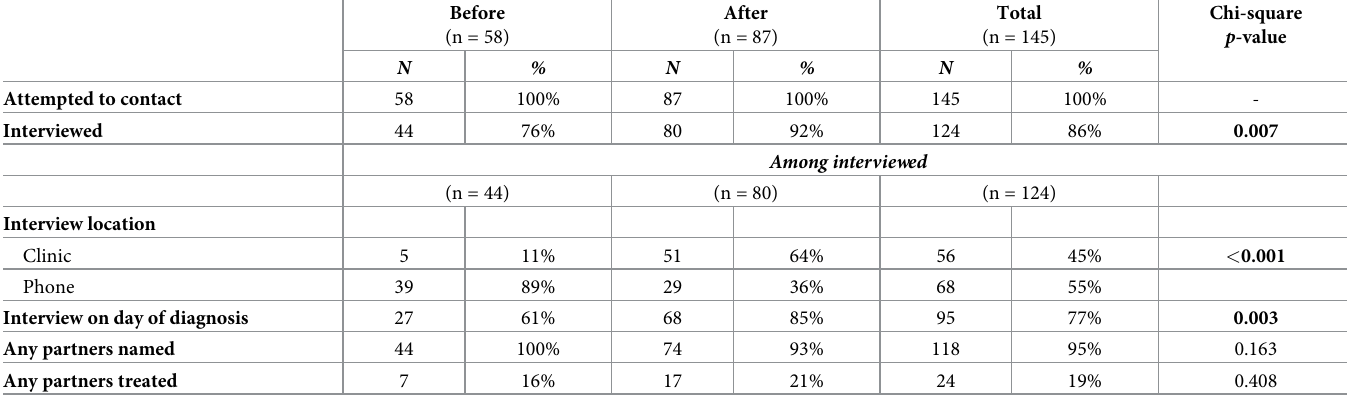
Table 2. Partner notification outcomes before and after implementation of an on-site DIS at an STD